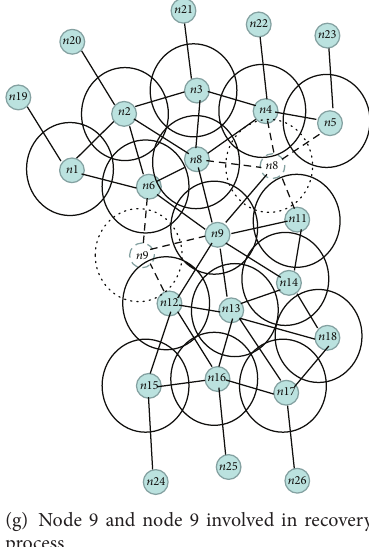
Figure 3: Example that illustrates the operation of proposed technique.